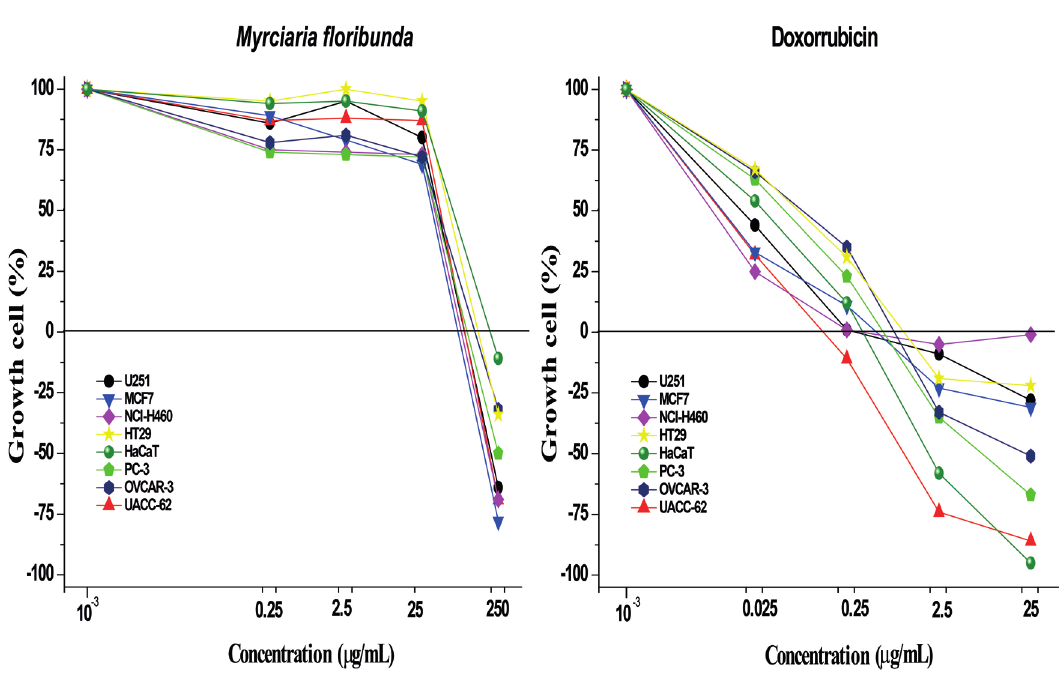
Figure 1 - Percentage of cell growth after 48h treatment with different concentrations (0.25, 2.5, 25 and 250 μg/mL) of the ethyl acetate extract from Myrciaria floribunda leaves and Doxorrubicin. Human tumor cell lines U251 (glioma), UACC- 62 (melanoma), MCF7 (breast), NCI-H460 (lung, non-small cells), PC-3 (prostate), OVCAR-3 (ovary) and HT29 (colon) and normal cell line (HaCat, immortalized human skin keratinocytes). Each point represents the mean and SD of three determinations. Continuous horizontal line: Total Growth Inhibition (TGI). TGI values (concentration eliciting 0% of cell proliferation) were determined through non‐linear regression analysis; dose range tested 0.25 –250 μg/mL.